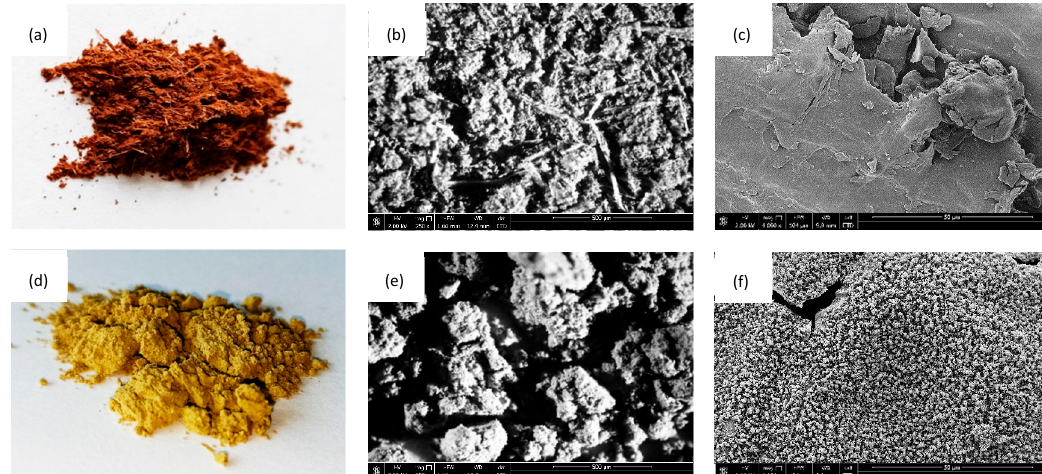
Figure 2. Optical and scanning electron microscope images of ( a – c ) pristine coir fibers and ( d – f ) coir-fiber filler treated with henna.